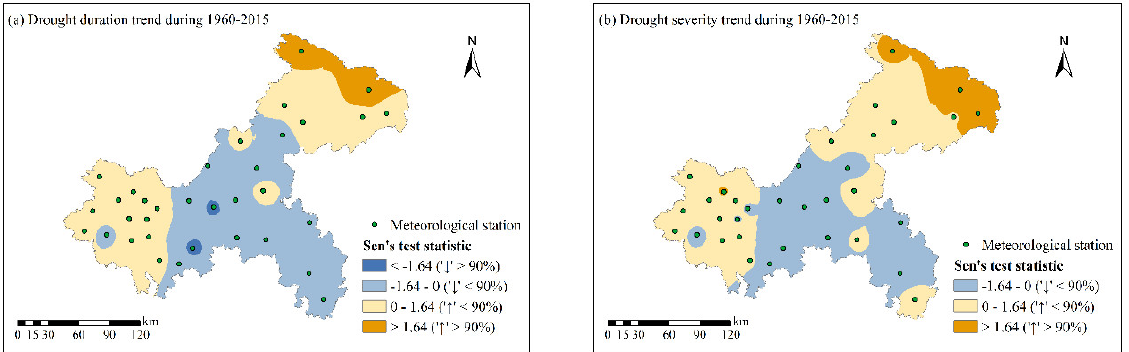
Figure 8. Spatial trend evolution of annual drought duration ( a ) and drought severity ( b ) of long persistent drought events from 1960 to 2015.